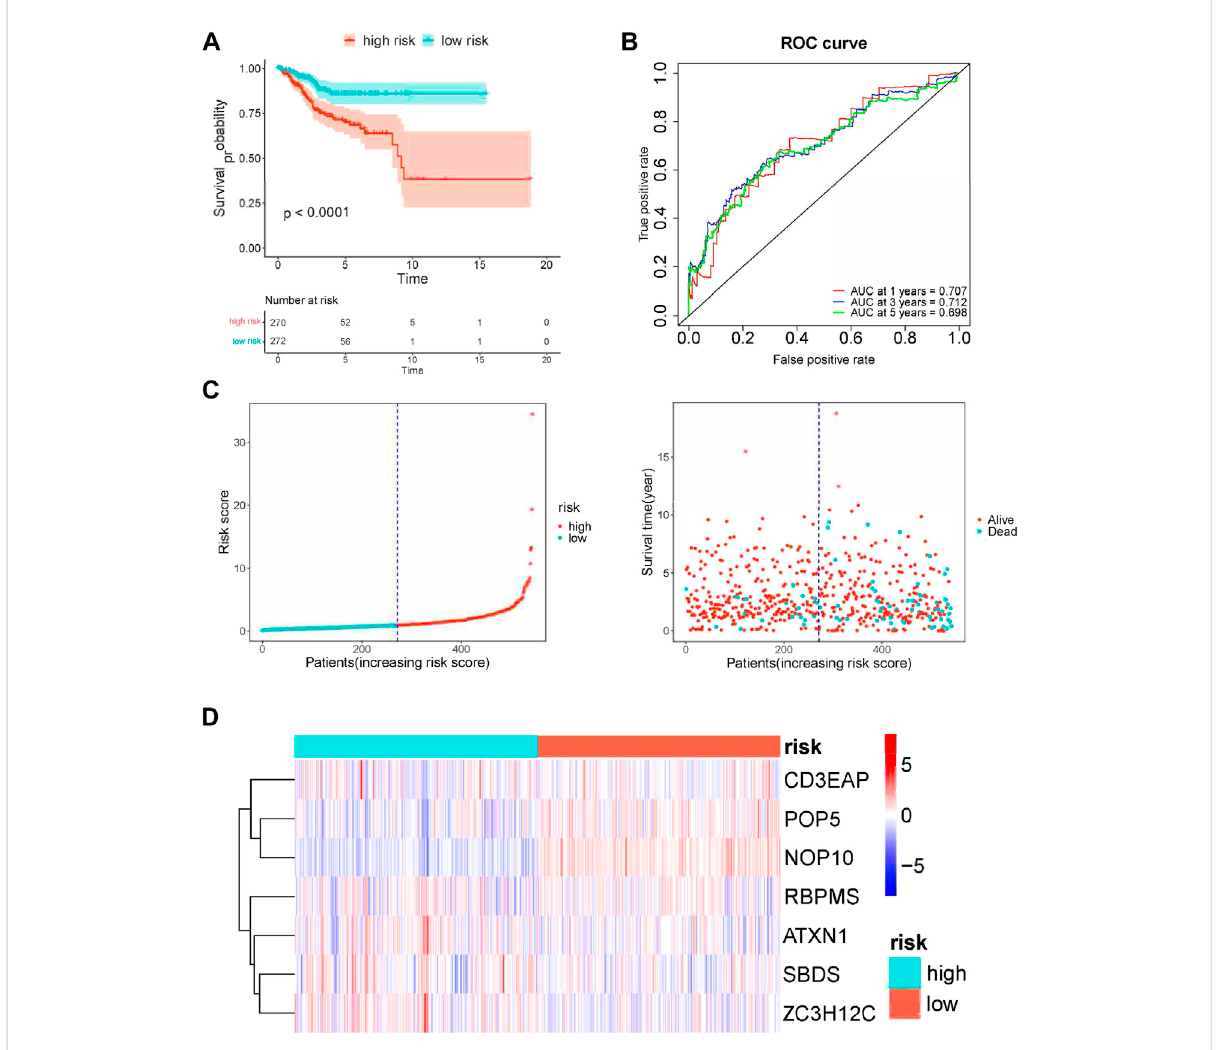
FIGURE 6 Risk score analysis of seven-gene prognostic model in TCGA UCEC cohort. (A) Kaplan – Meier curves of OS of high- and low-risk groups ( p < 0.0001). (B) ROCcurveforjudgingtheaccuracyofthesignature. (C) Thedistributionofriskscores,geneexpressionlevelsandpatientsurvivalstatus. The dotted line represents the median cut point and divides patients into low-risk and high-risk groups. (D) The heatmap of the seven hub genes expression pro fi les in the